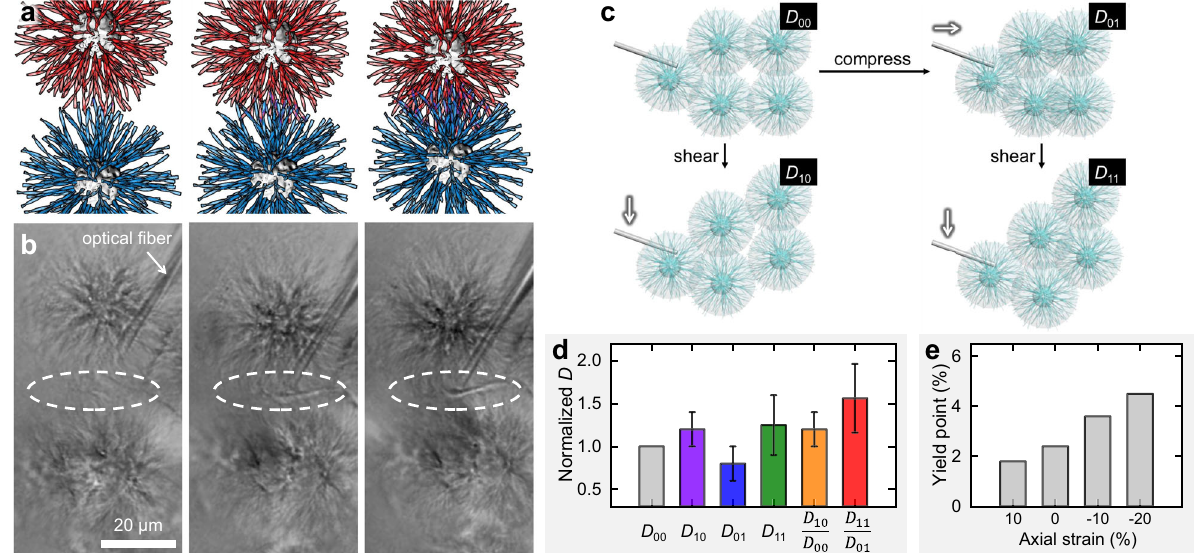
Fig. 4 Microscopic insights into aster-aster interpenetration. a , b Formation of an intersection is followed in real time by pushing one aster against another with an optical fi ber. c A schematic diagram showing the protocol to deform a cluster of asters. In our denotations, D represents the average distance between neighboring aster centers, while the fi rst subscript indicates unsheared (0) or sheared (1) and the second subscript uncompressed (0) or compressed (1). d A bar diagram showing measured D values averaged over measurements on fi ve different clusters. Error bars represent standard deviations ( n = 5). e Yield point as a function of axial strain (data taken from Fig.